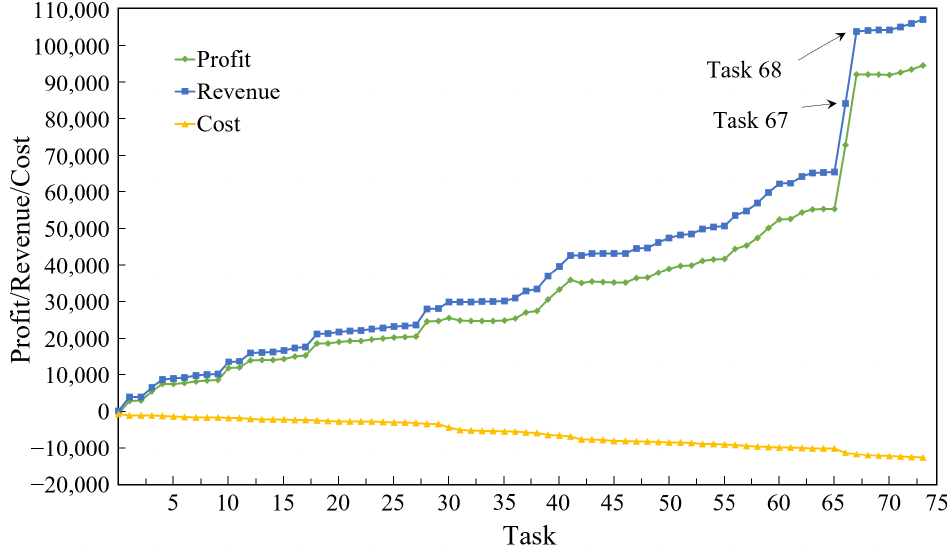
Figure 10. The relationships among task profit, revenue, and cost.